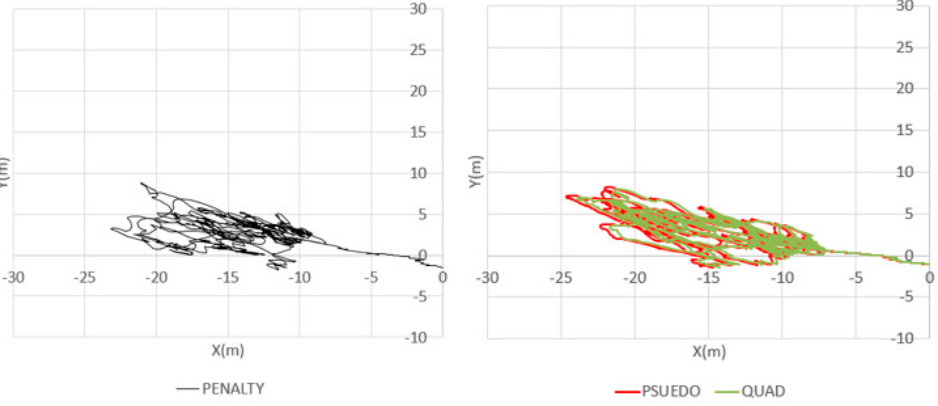
Figure 14. Surge and Sway Trajectories by Three Different Thrust-Allocation Algorithms. Table 9. Mean Value and Standard Deviation by Three Different Thrust-Allocation Algorithms.